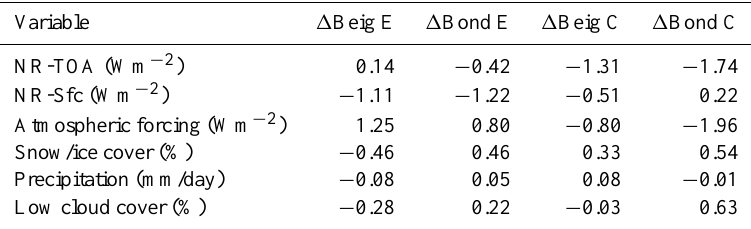
Table 4. Annual average differences in TOA net radiation (NR-TOA), surface net radiation (NR-Sfc), atmospheric forcing, snow/ice cover, precipitation and low cloud cover for the Indian region (4 ◦ –40 ◦ N and 65 ◦ –105 ◦ E) for the Beig and Bond emissions with 1 denoting differences between simulations for changes from 1990 to 2000 for changing emissions (E) and changes from climate (C). Simulations represented include the direct and indirect